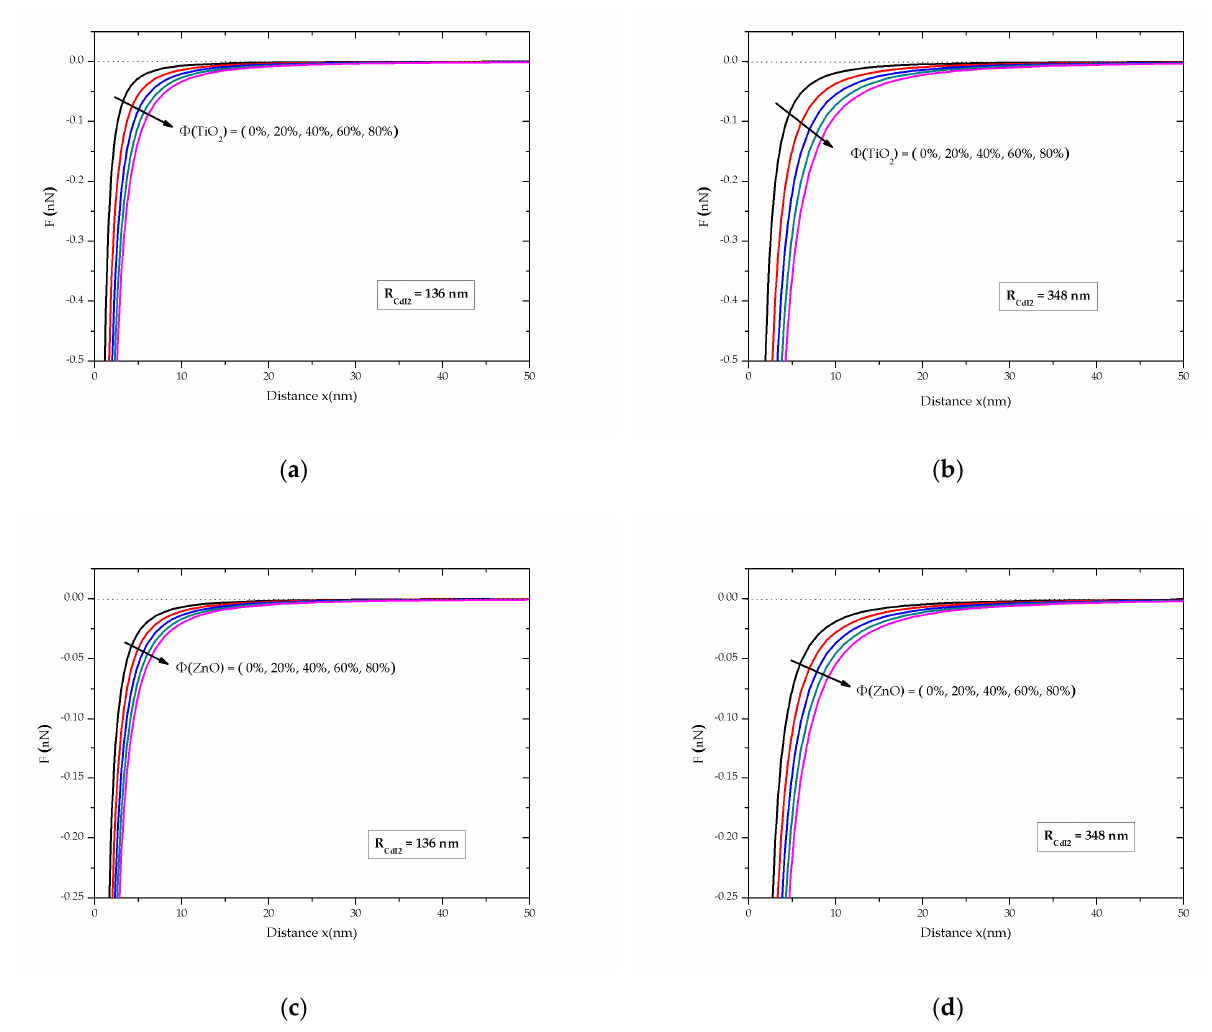
Figure 10. VdW forces F between CdI 2 and PANI/NPs across water medium as a function of the separating distance x and for Table 2. (a) PANI/TiO 2 with Rc = 136 nm, ( b ) PANI/TiO 2 with Rc = 348 nm, ( c ) PANI/ZnO with Rc = 136 nm and ( d ) PANI/ZnO with Rc = 348 nm.